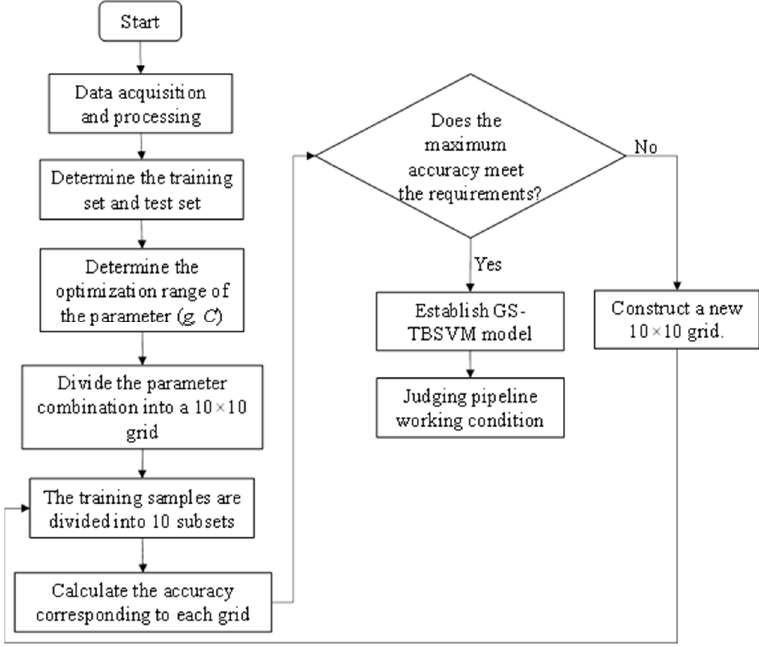
Figure 2. Optimization process of the TBSVM model.